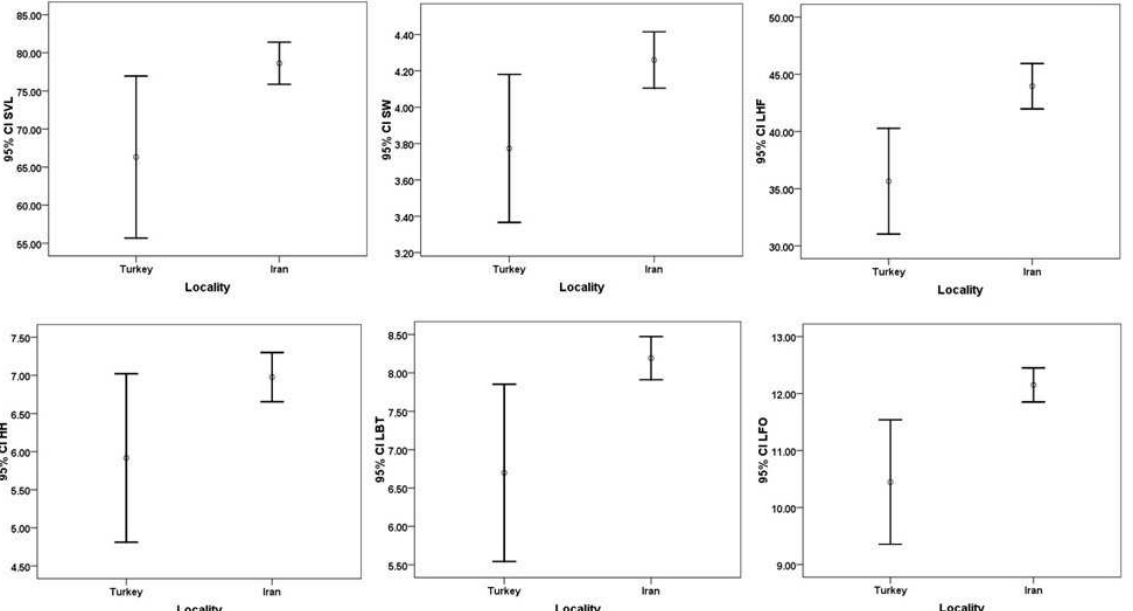
F IGURE 3. The ordination of geographic variation between the Iranian and Turkish populations of Trachylepis vittata (females) for significant ( P ≤ 0.05) morphological